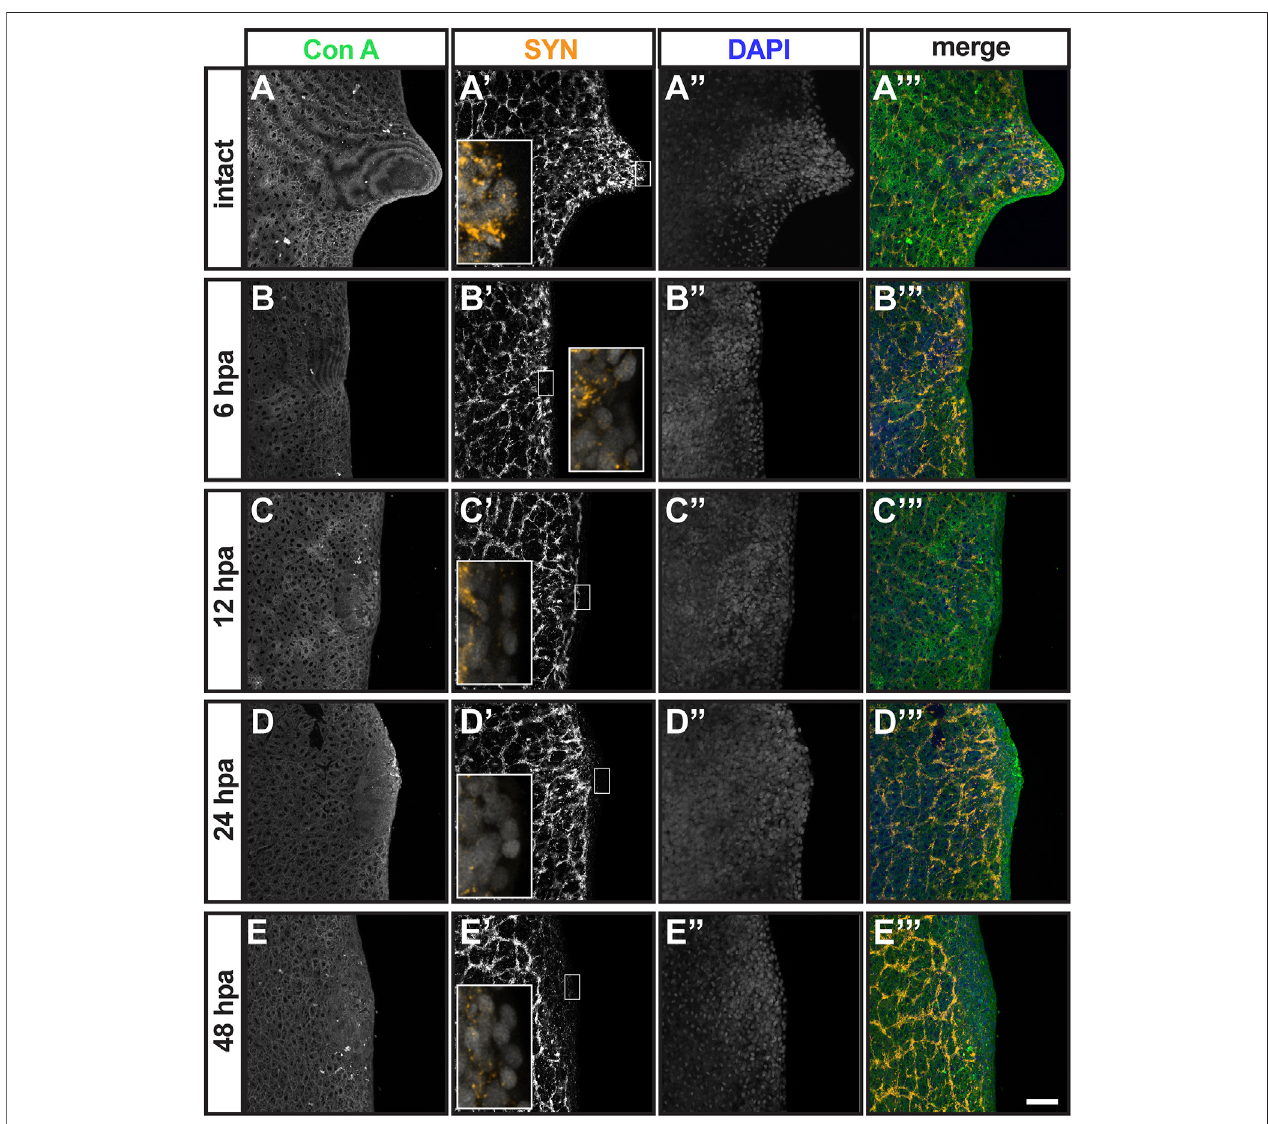
FIGURE5| Analysisofepithelialandneuronaldistribution duringthe fi rst2 dayspost-auricleamputation.Maximumintensityprojectionofconfocalz-stackimages from intact (A – A ”’ ) and auricleamputees 6 hpost-amputation [6hpa; (B – B ”’ ) ,12hpa (C – C ”’ ) ,24hpa (D – D ”’ ) and48hpa (E – E ”’ ) ],illustratethedistribution ofepithelia stained with Concanavanil A [ConA; (A – E) ; green in (A ”’– E ”’ ) ] and neuronal projections stained with anti-synapsin [SYN; (A ’– E ’ ) ; orange in (A ’– E ’ ) insets and (A ’”– E ”’ ) . DAPI staining of cell nuclei (A ”– E ” ) ; blue in (A ”’– E ”’ ) ] reveals the general position of cells. Scale (cid:2) 0.1 mm. Insets in (A ’– E ’ ) show 5-fold magni fi ed views.